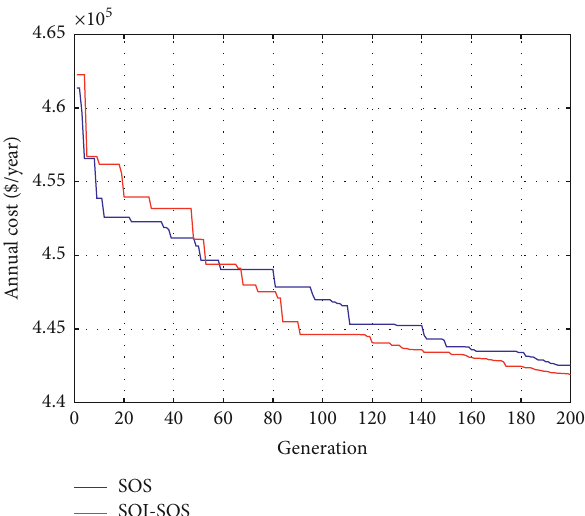
Figure 20: Convergence curves of the total cost of the 119-bus system with the mixed load model.